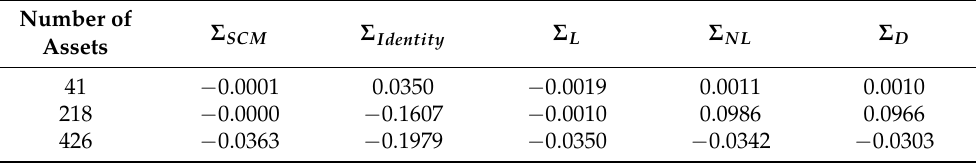
Table 9. The difference in the out-of-sample variance between Σ ∗ and the alternative estimation with all assets (the significance level is